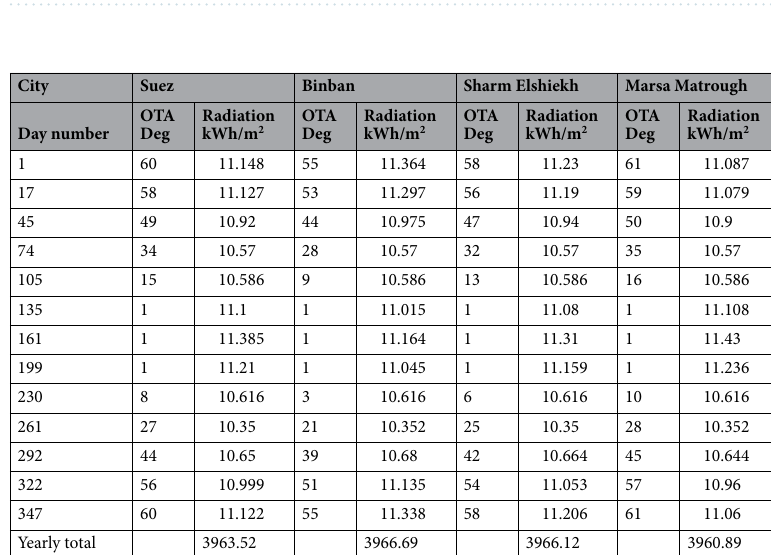
Figure 6. Solar radiation versus optimal daily TA for some cities in Egypt.